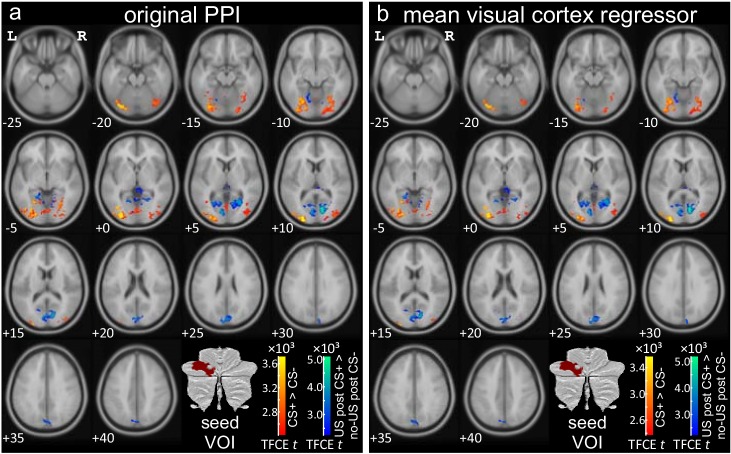
Reanalysis of PPI data to exclude "bleed over" from visual cortex.To exclude this possibility, data were reanalyzed using the mean signal modulation in the occipital lobe as first level nuisance regressor in analogy to the method applied by Buckner et al. (2011) (b). For comparison, data of the original analysis are shown in (a), which is identical to Figure 6 in the main manuscript. Note that the main results did not change, that is functional connectivity of the cerebellum was increased with visual cortical areas when comparing CS+ with CS- trials. Data are shown at p<0.05 FWE corrected level after TFCE application. CS = conditioned stimulus; FWE = familywise error; L = left; PPI = psychophysiological interaction; R = right; TFCE = threshold-free cluster-enhancement; US = unconditioned stimulus; VOI = volumes of interest.